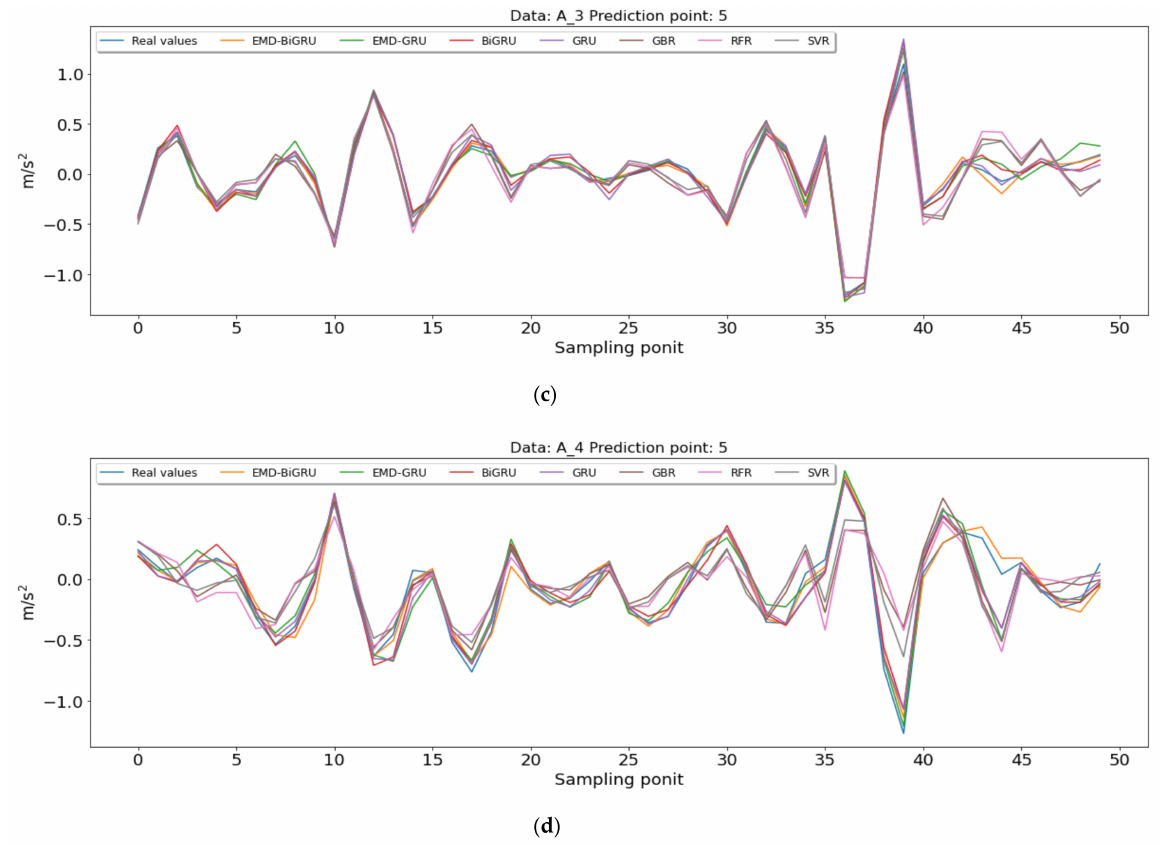
Figure 13. Comparisons results for different data sets using various algorithms. ( a ) Comparisons of predicted results for the A_1 data set using different algorithms. ( b ) Comparisons of predicted results for the A_2 data set using different algorithms. ( c ) Comparisons of predicted results for the A_3 data set using different algorithms. ( d ) Comparisons of predicted results for the A_4 data set using different